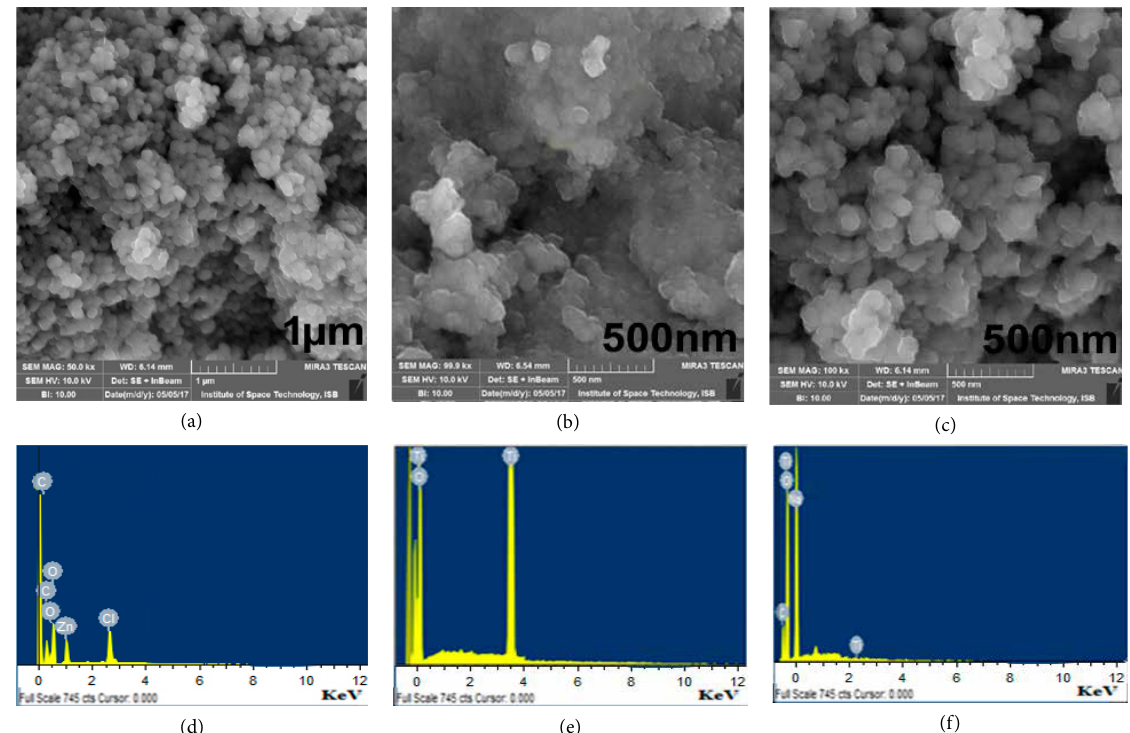
Figure 3: SEM and EDX data of synthesized formulations. (a) TiO